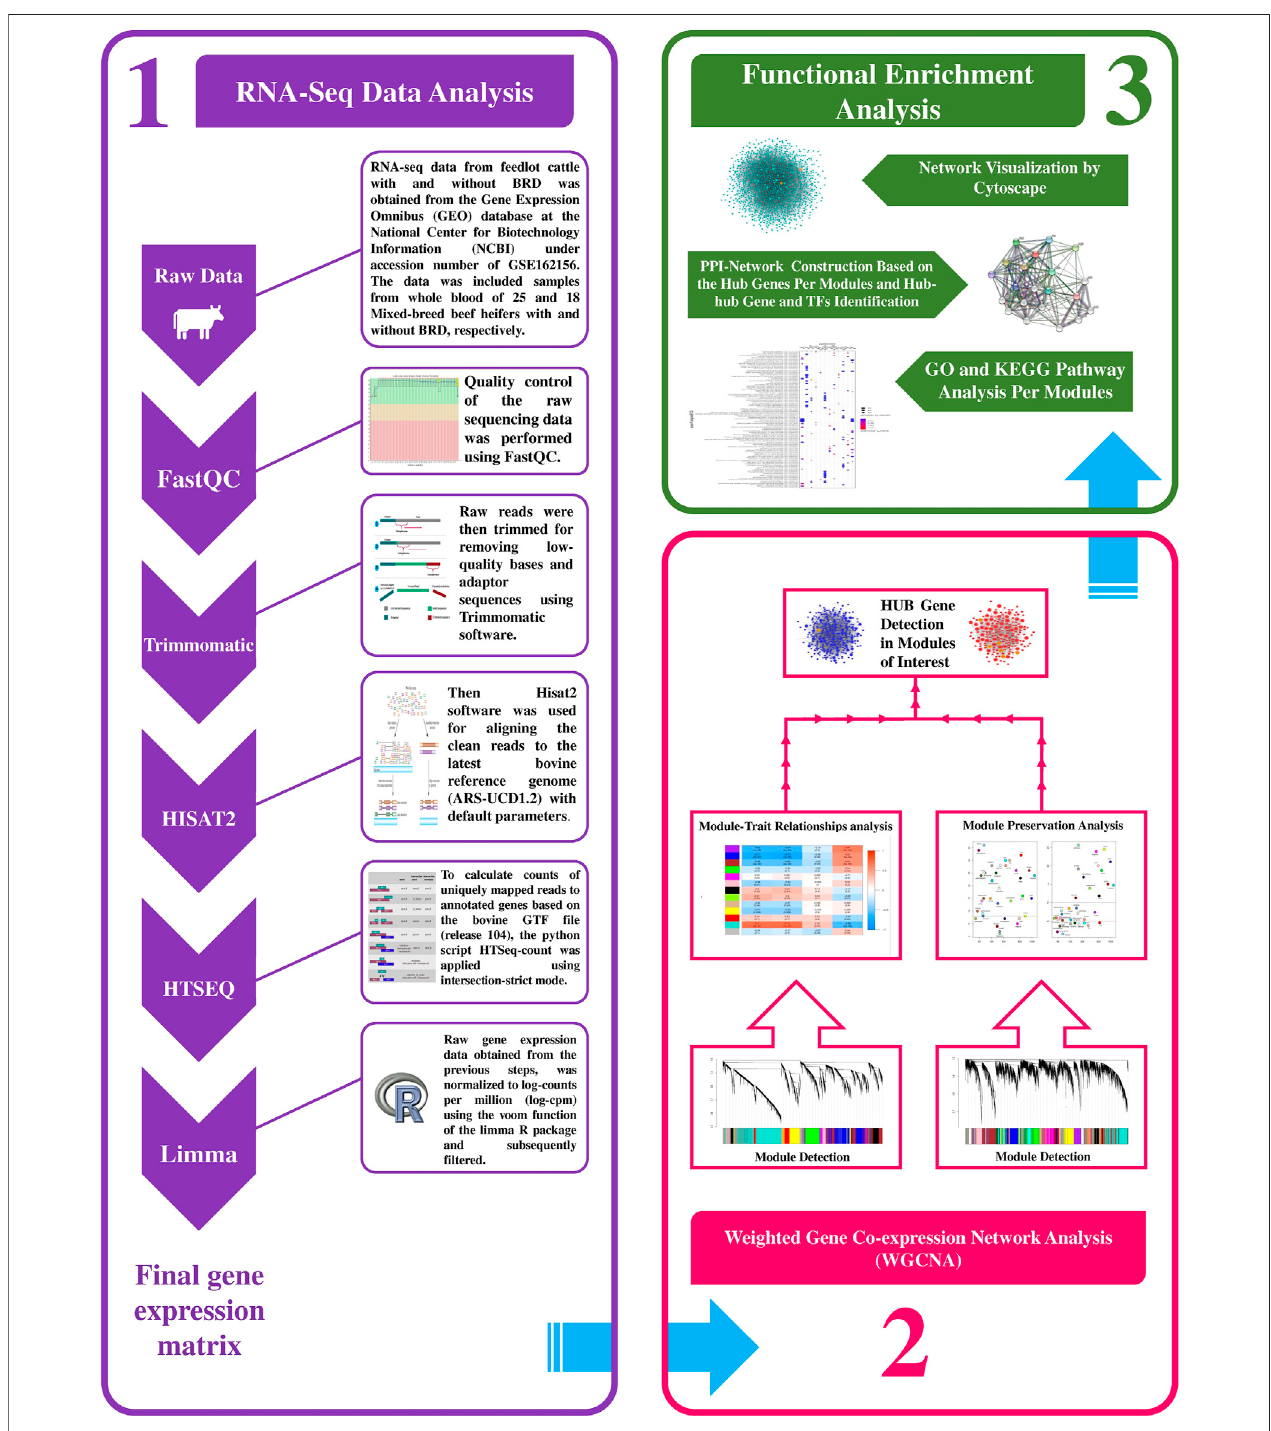
FIGURE 1 | Schematic pipeline for RNA-seq data analysis and weighted gene coexpression network construction in this study.